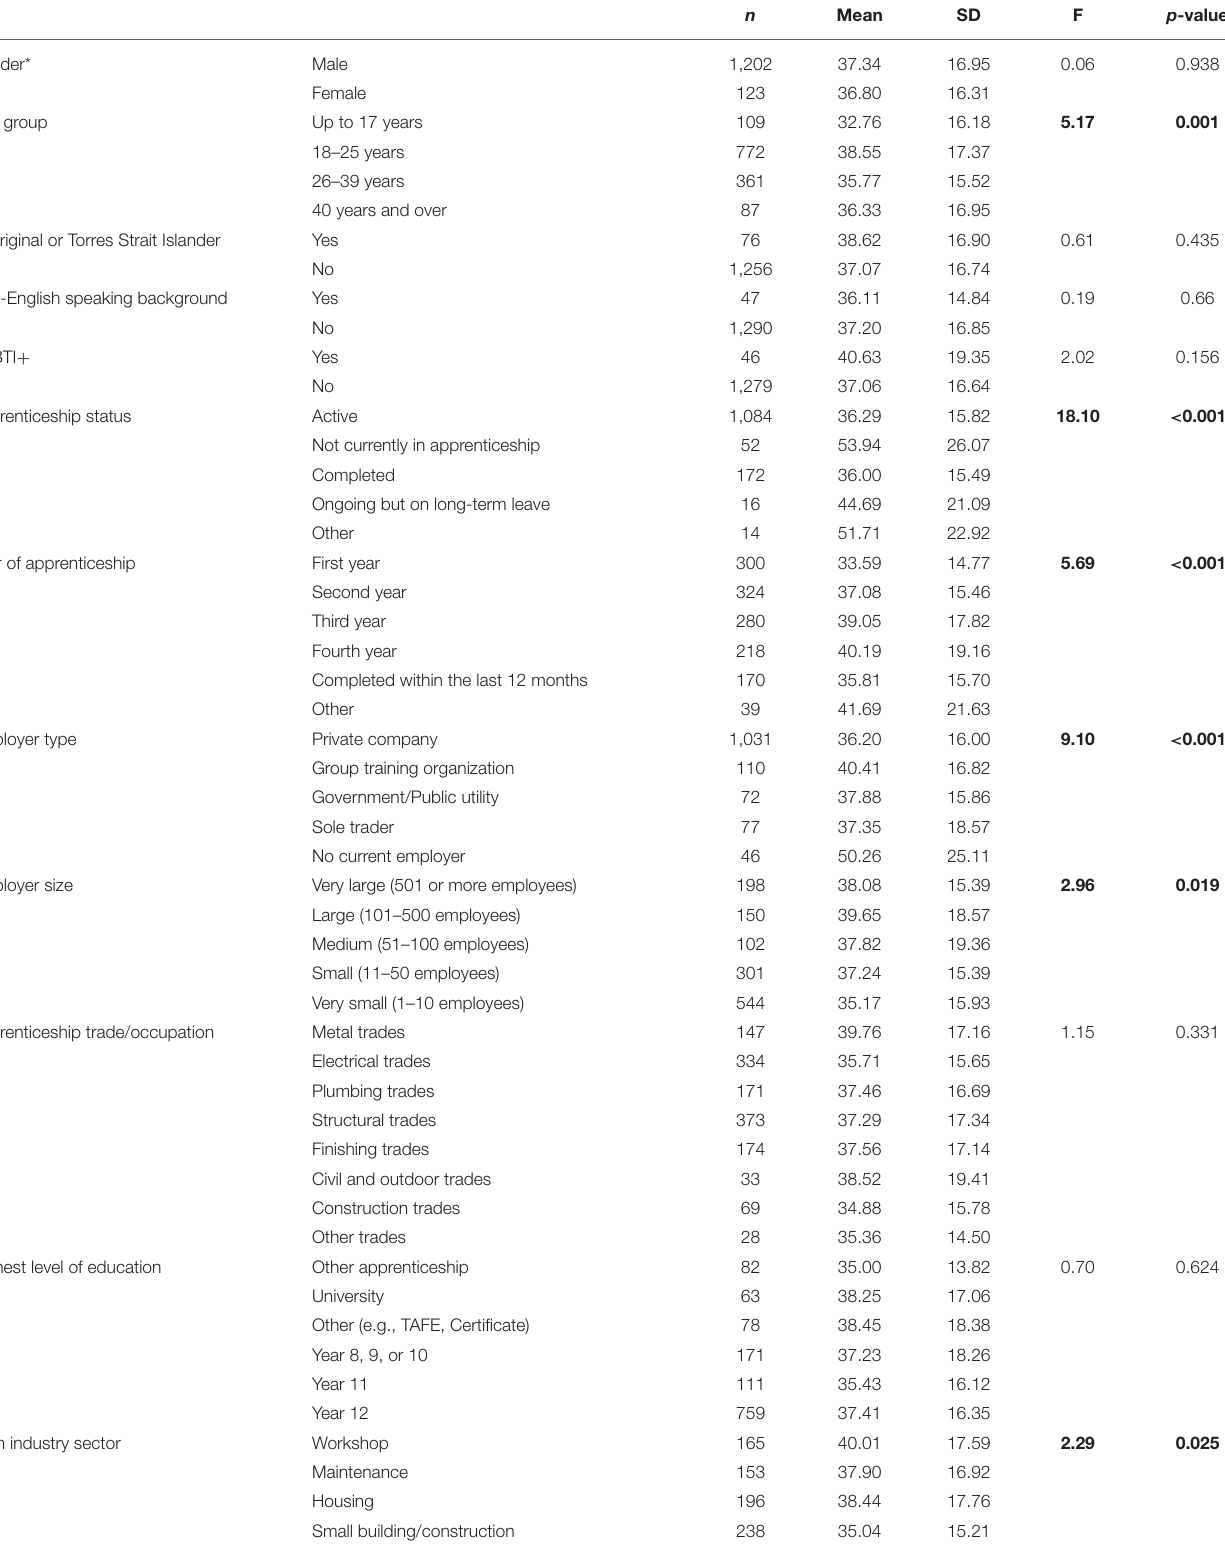
TABLE 4 | Mean scores of self-reported bullying (NAQ-R) by demographic and apprenticeship variables.